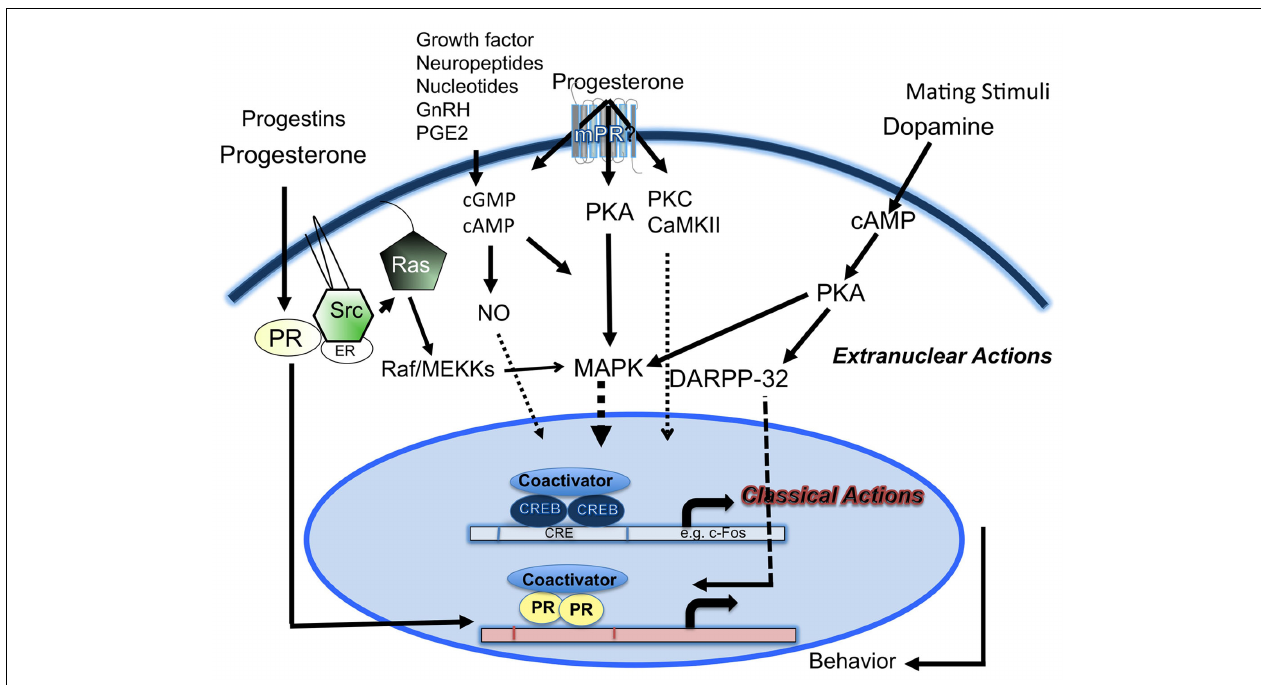
cause a decrease in phosphatase activity and an increase in phosphorylation of PR and/or its coactivators. Mating stimuli (VCS) and dopamine D 1 agonist can stimulate PKA activation. D 1 agonist-stimulated PKA-mediated pathway phosphorylates DARPP-32, which inhibits PP1, leading to the activation of CREB/PR/coactivators.VCS-stimulated PKA activation can also interact with MAPK cascade. Neuropeptides, nucleotides, GnRH, and PGE 2 can